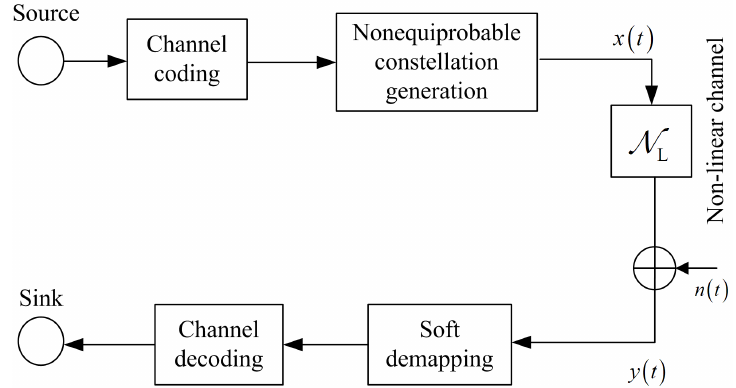
Figure 1. The system model using the proposed nonequiprobable constellation over non-linear